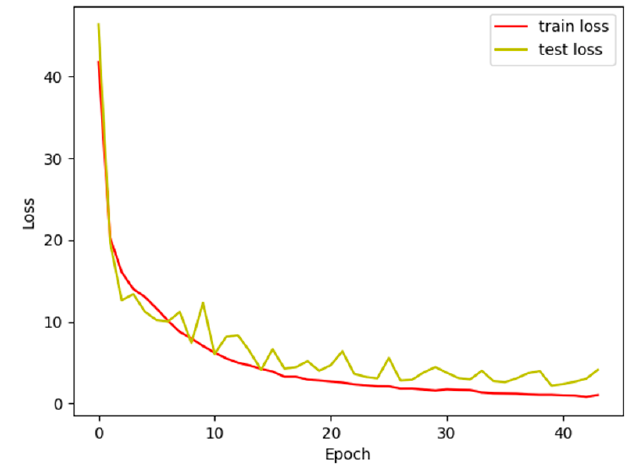
Figure 8. AAPFE pre-training loss curve.